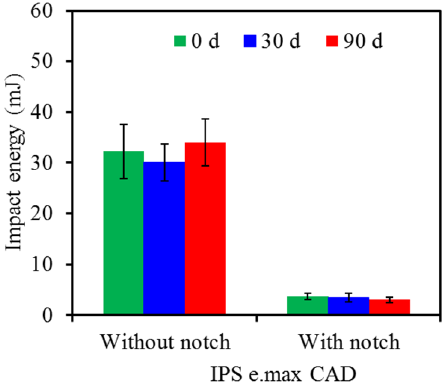
Figure 4. Impact energy of IPS e.max CAD without and with notch before and after soaking in pH 7 artificial